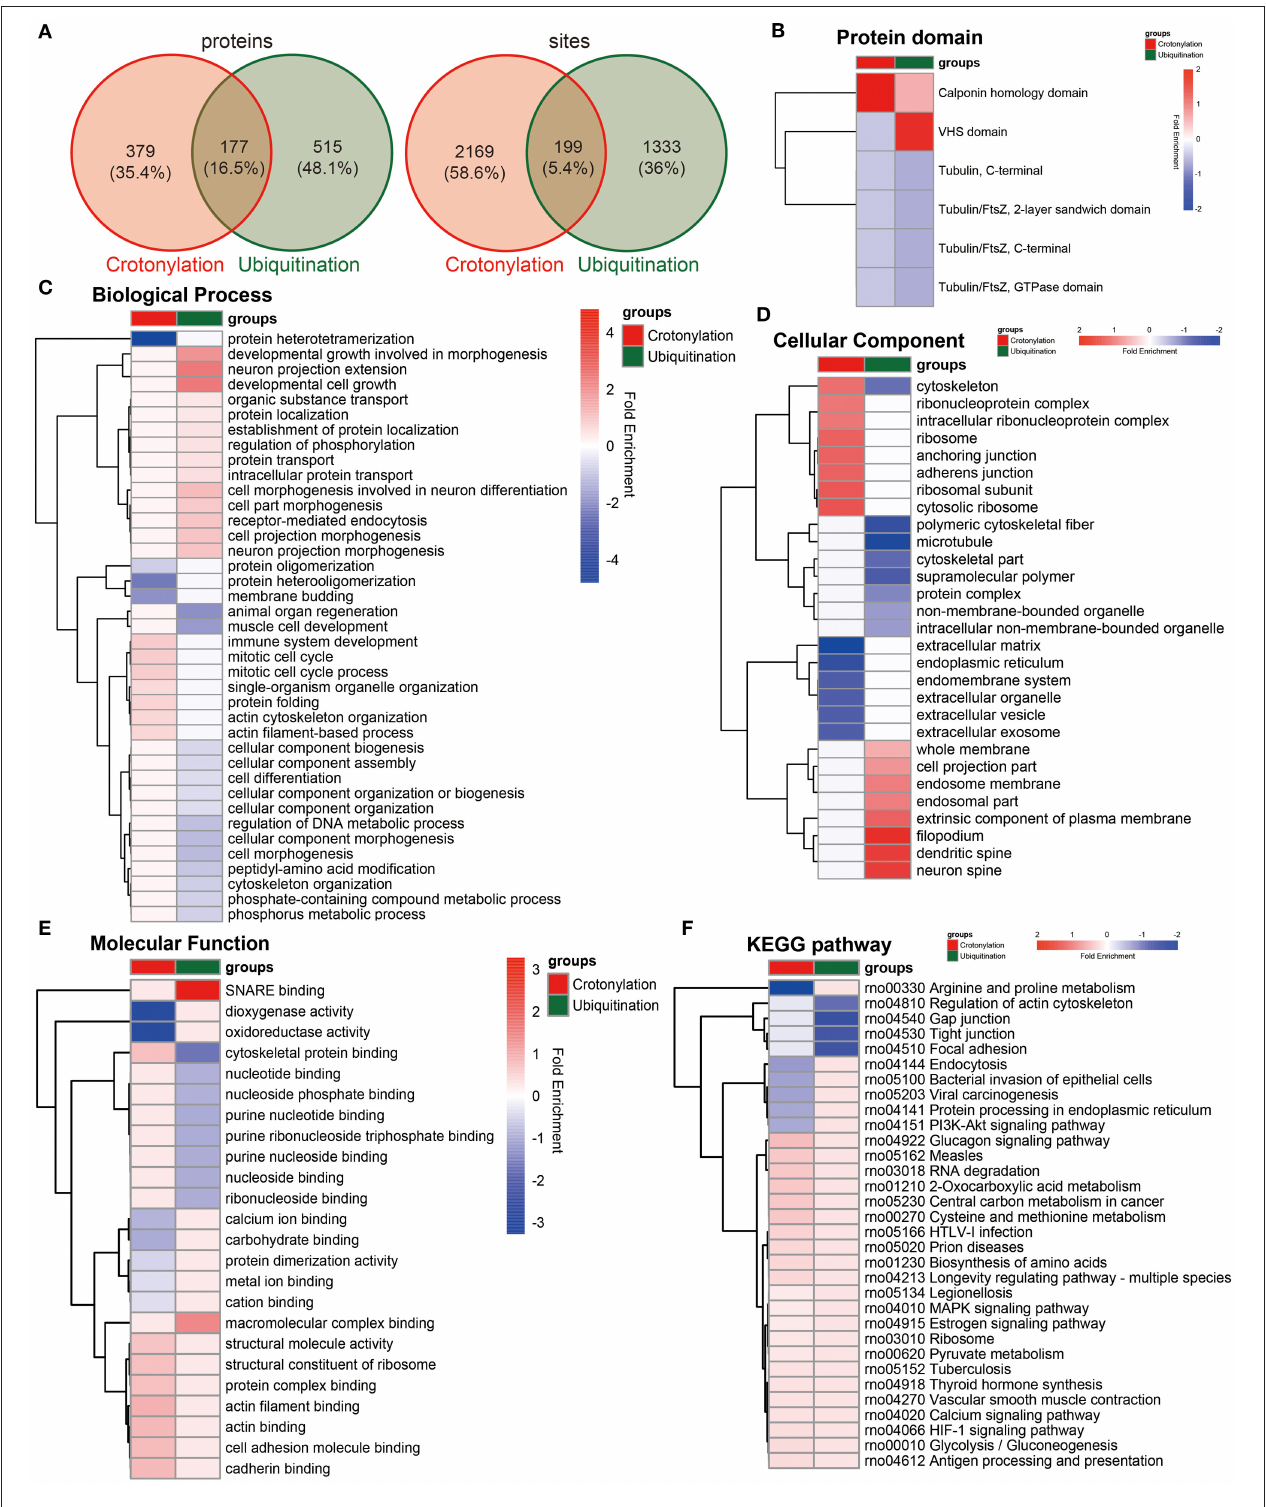
FIGURE 5 | Cross talk results of the quantitative and enrichment analysis between crotonylation and ubiquitination. (A) The identified proteins and modification sites of lysine crotonylation and ubiqutination. (B–F) The heatmaps show the different and similar enrichment analyses of lysine crotonylation and ubiqutination, including protein domain (B) , biological process (C) , cellular component (D) , molecular function (E) , and KEGG pathway (F) .